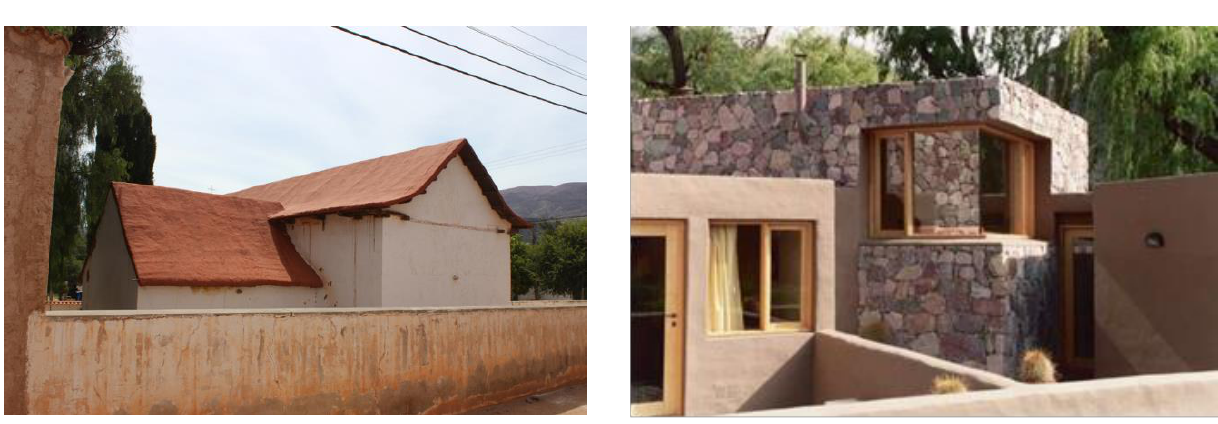
Figure 4. View of the current characteristics of the roof in the Figure 5. Details in one of the hotels of Purmamarca © Chapel of Uquía © Authors.